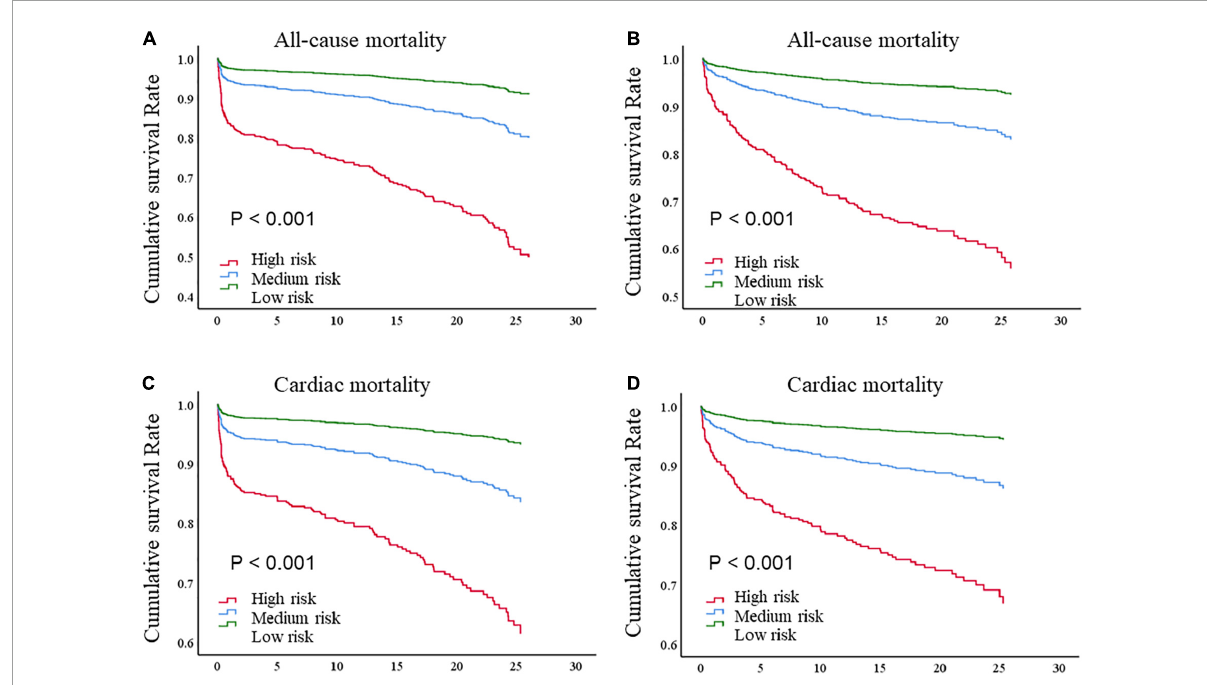
FIGURE3 Kaplan–Meier survival curve of (A) all-cause death for STEMI patients; (B) all-cause death for NST-ACS patients; (C) cardiac death for STEMI patients; (D) cardiac death for NST-ACS patients; by risk levels according to dynamic BI-based risk stratification. BI, Barthel index; STEMI, ST-segment elevation myocardial infarction; NST-ACS, non-ST elevation acute coronary